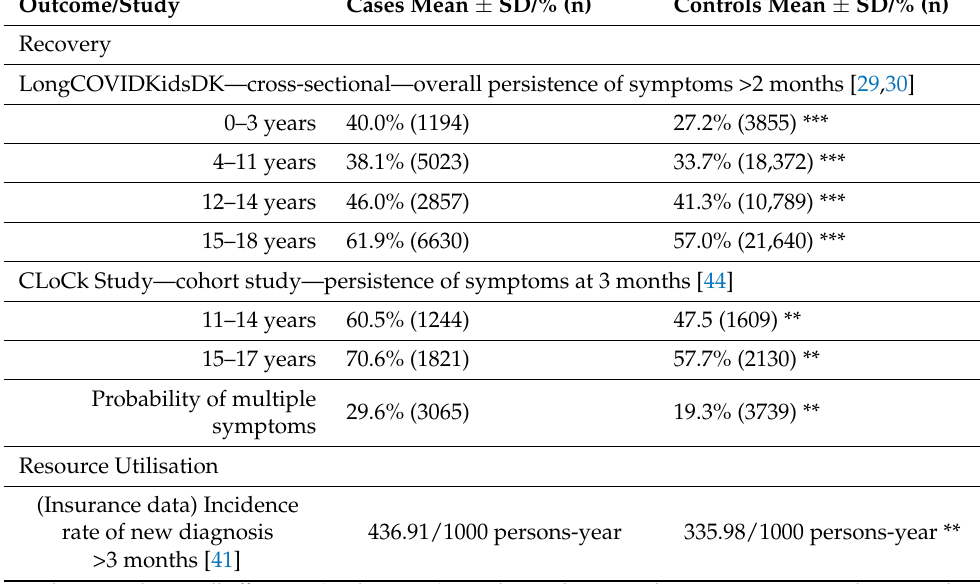
Table 2. Cont. Outcome/Study Cases Mean ± SD/% (n) Controls Mean ± SD/% (n)